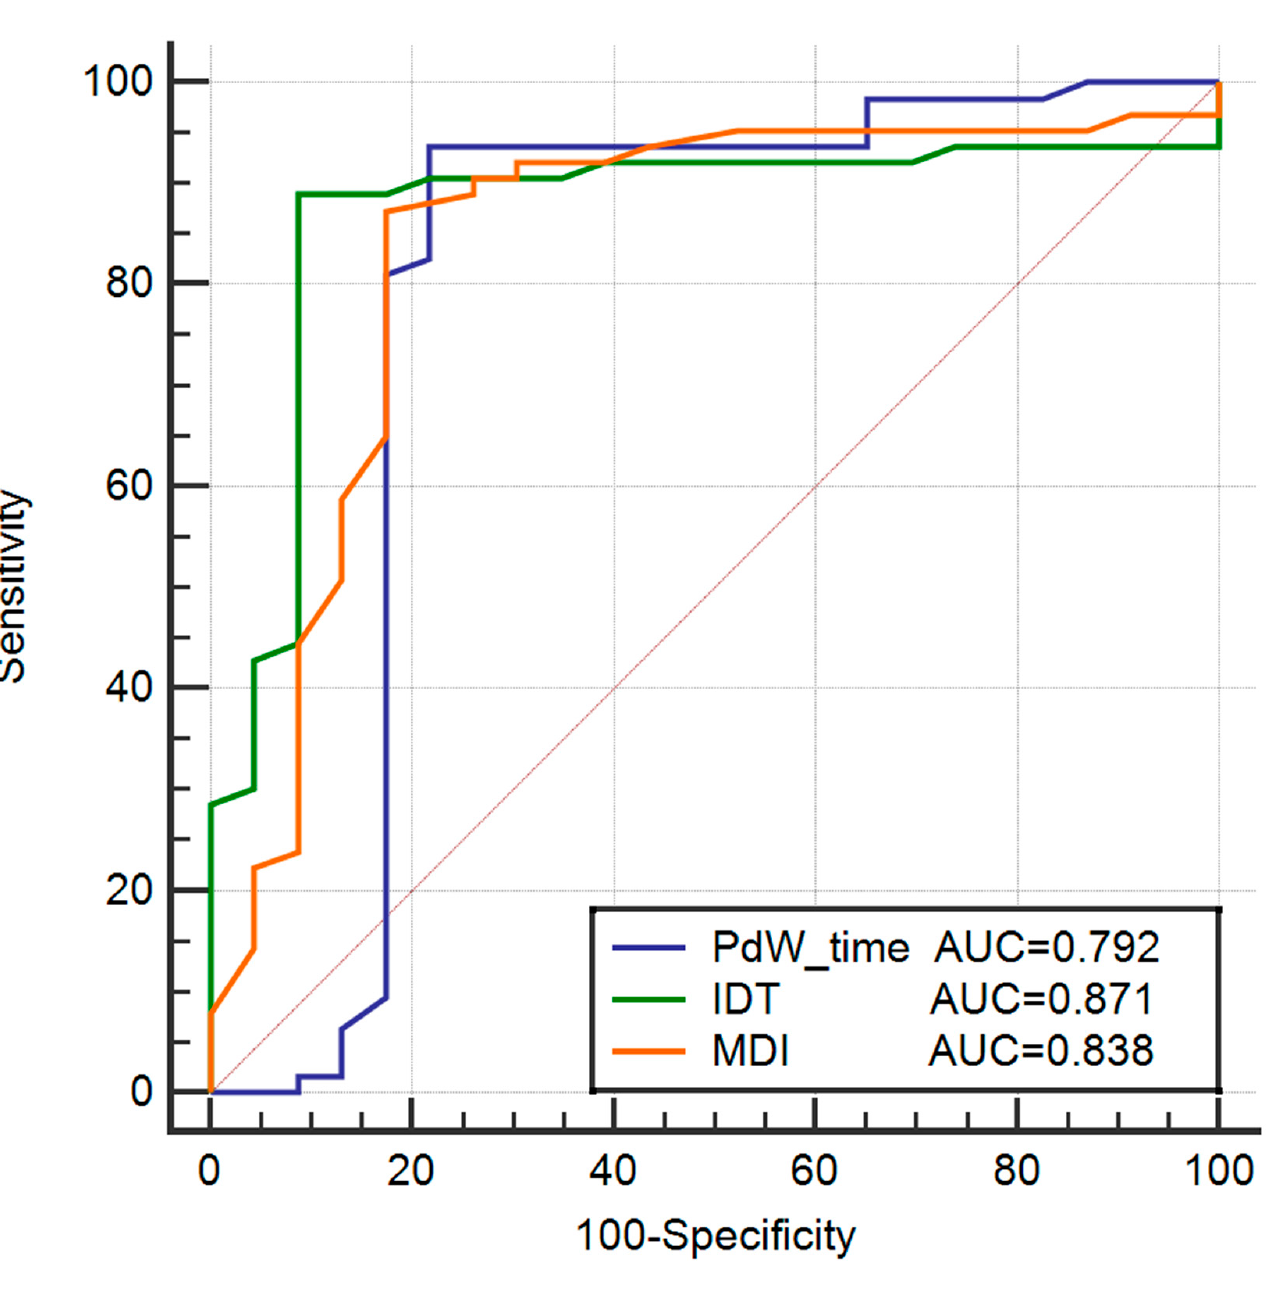
Figure 5. The ROC curve for diagnosing IVAs originating from the CVS. Pdw, pseudo delta wave; IDT, intrinsicoid deflection time; MDI, the maximum deflection index; AUC, Area Under